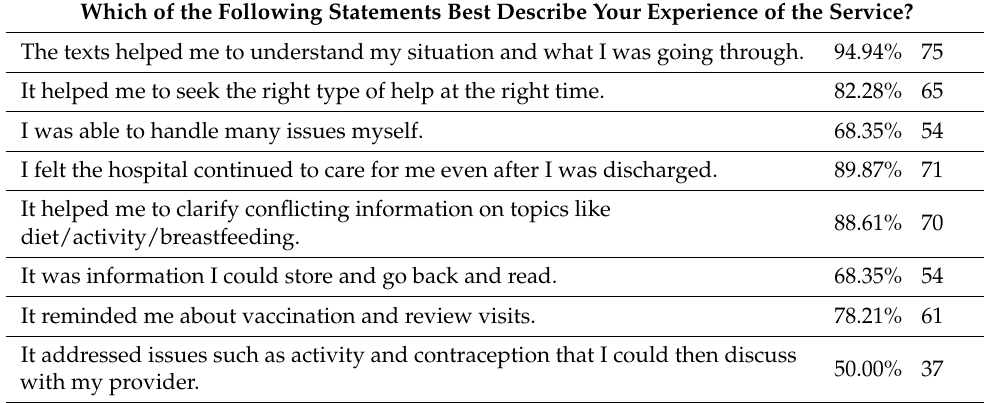
Table 3. Value and benefits of the service ( n =